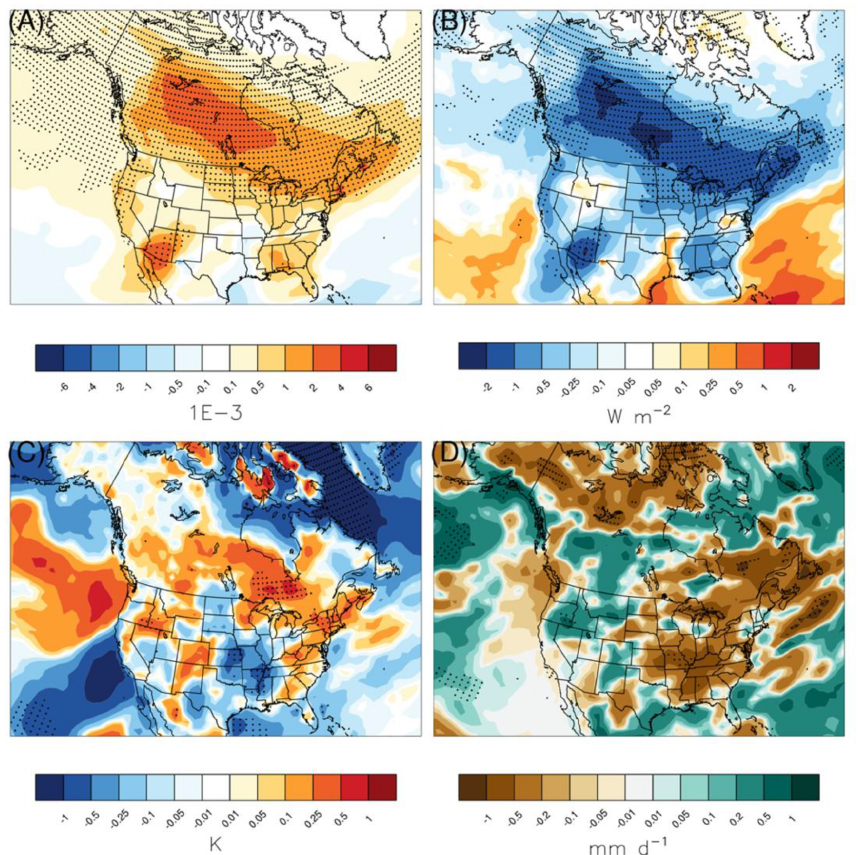
Figure 6. Spatial distribution of decadal-mean summer (JJA) wildfire-induced future changes ((2050 ALL –2050 WEF )–(2000 ALL –2000 WEF )). (a) Aerosol absorption optical depth at 550nm, (b) aerosol direct radiative forcing at the surface, (c) lower-tropospheric stability calculated as the difference between the potential temperature at 900 and 1000hPa, (d) summer-averaged precipitation rates over North America. Areas marked with black dots indicate grids where changes are significant at the 95% confidence